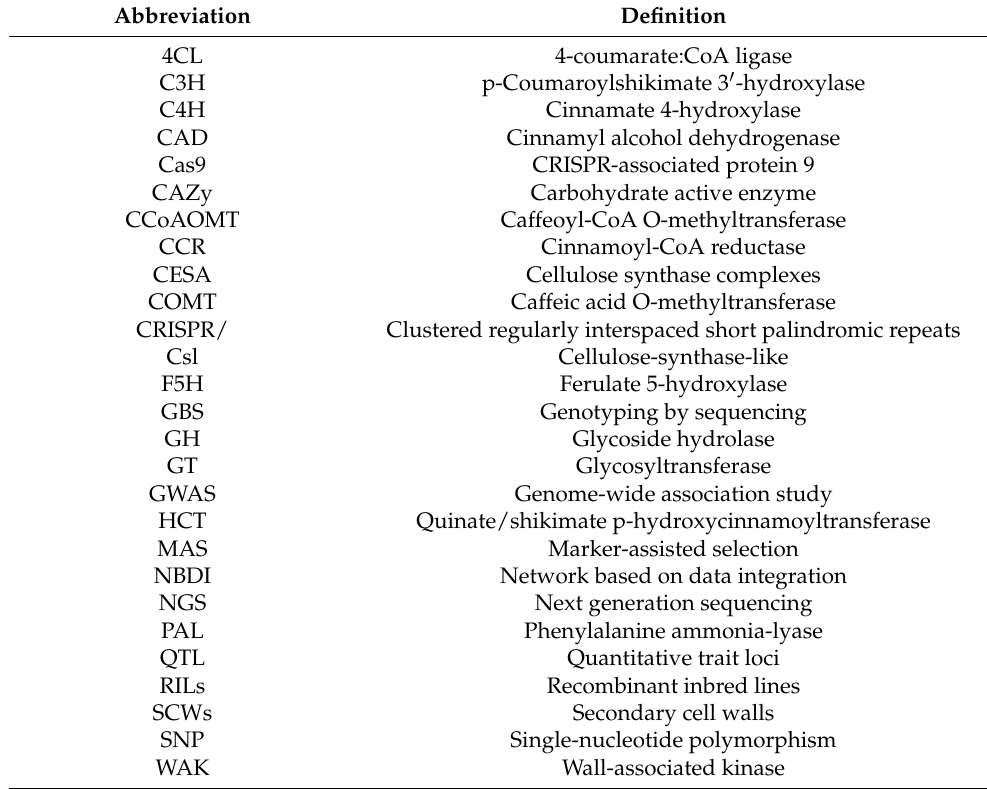
Table 1. List of abbreviations used in this